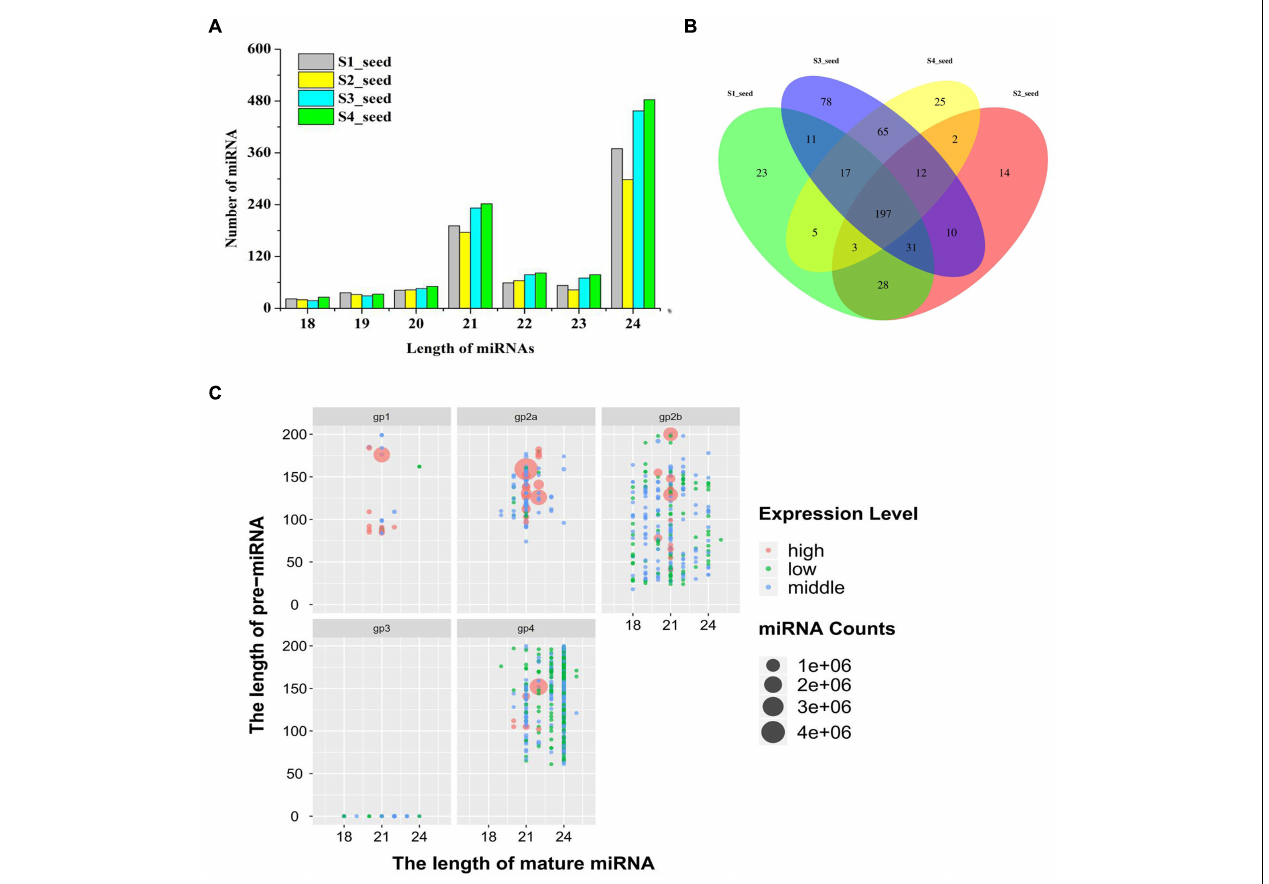
FIGURE 2 | (A) Number of different-length miRNA distribution in different development periods of sesame seed, (B) Venn diagrams of differentially expressed miRNAs in different development periods of sesame seed, and (C) length of miRNA distribution of five groups for expression level (high-level expression over average; middle-level expression > 10 but less than average; low-level expression <